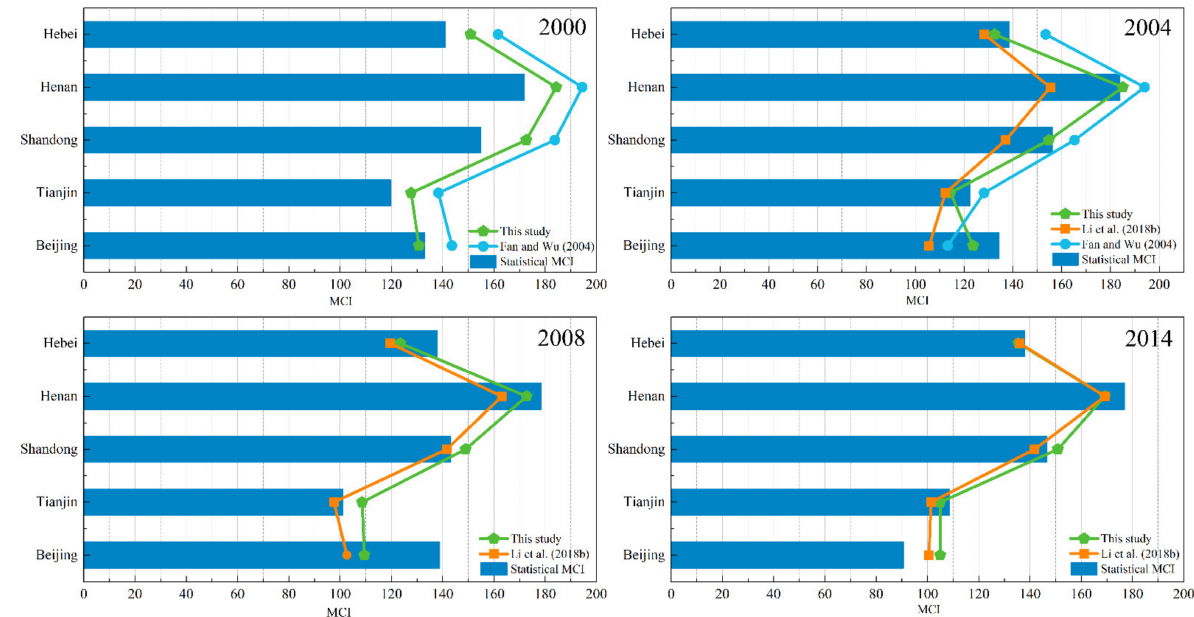
Figure 6. Comparative analysis between the results of this study and other research results.